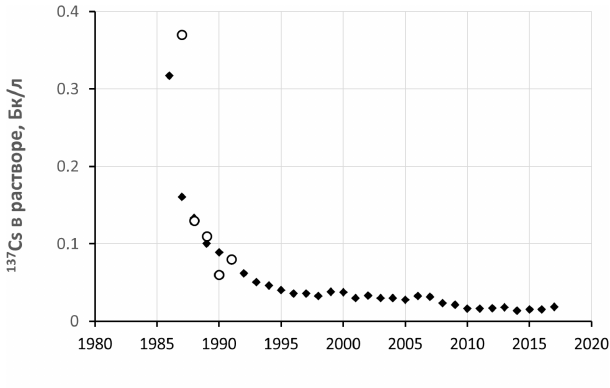
Figure 5. Comparison of the predicted time dependence of dis- solved 137 Cs activity concentrations in the Upa River based on re- constructed particulate 137 Cs from sediments in core C1 with